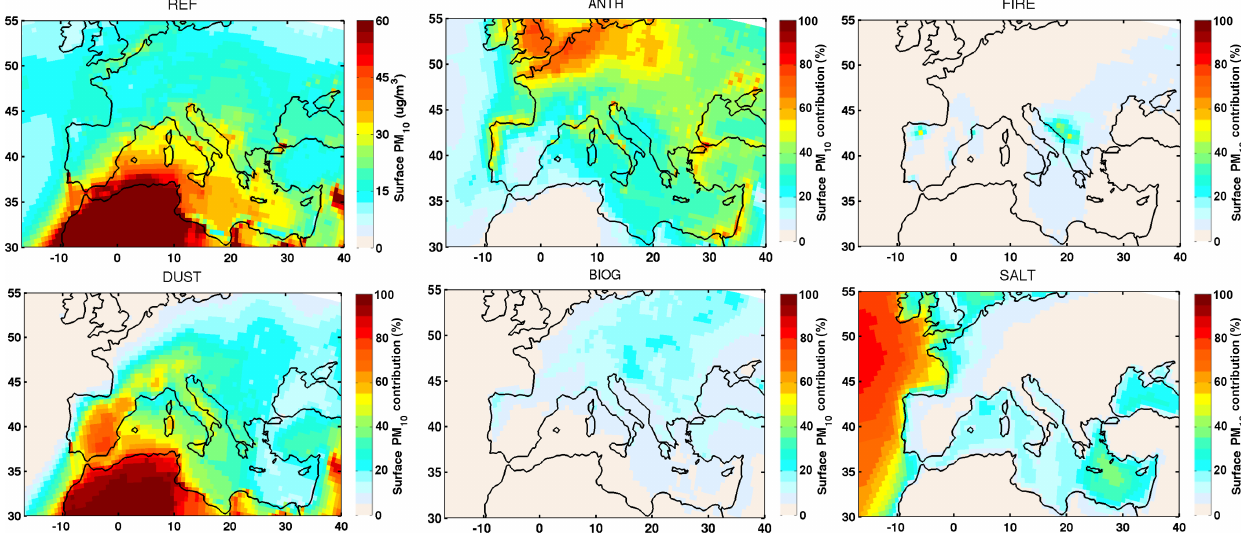
Figure 9. Relative contribution of each source type (i.e., the baseline simulation minus the sensitivity simulation where the respective source has been eliminated) to the simulated surface PM 10 , averaged over the period (1 June to 31 August 2012). The top left represents the reference surface concentration over the same